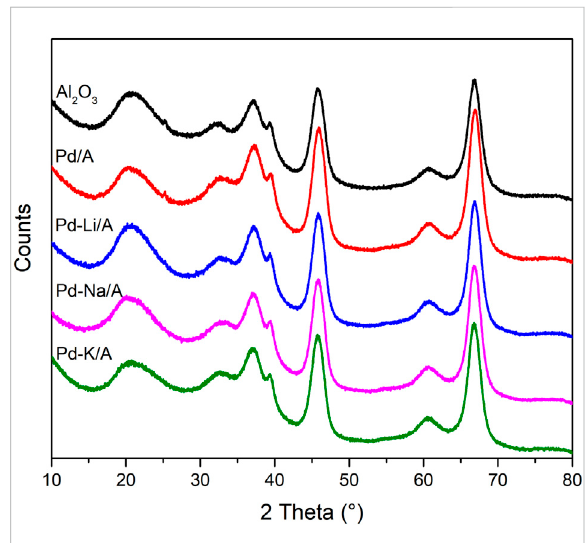
FIGURE 2 XRD patterns of Al 2 O 3 , Pd/A, and alkali metal (Li, Na, and K)- modi fi ed